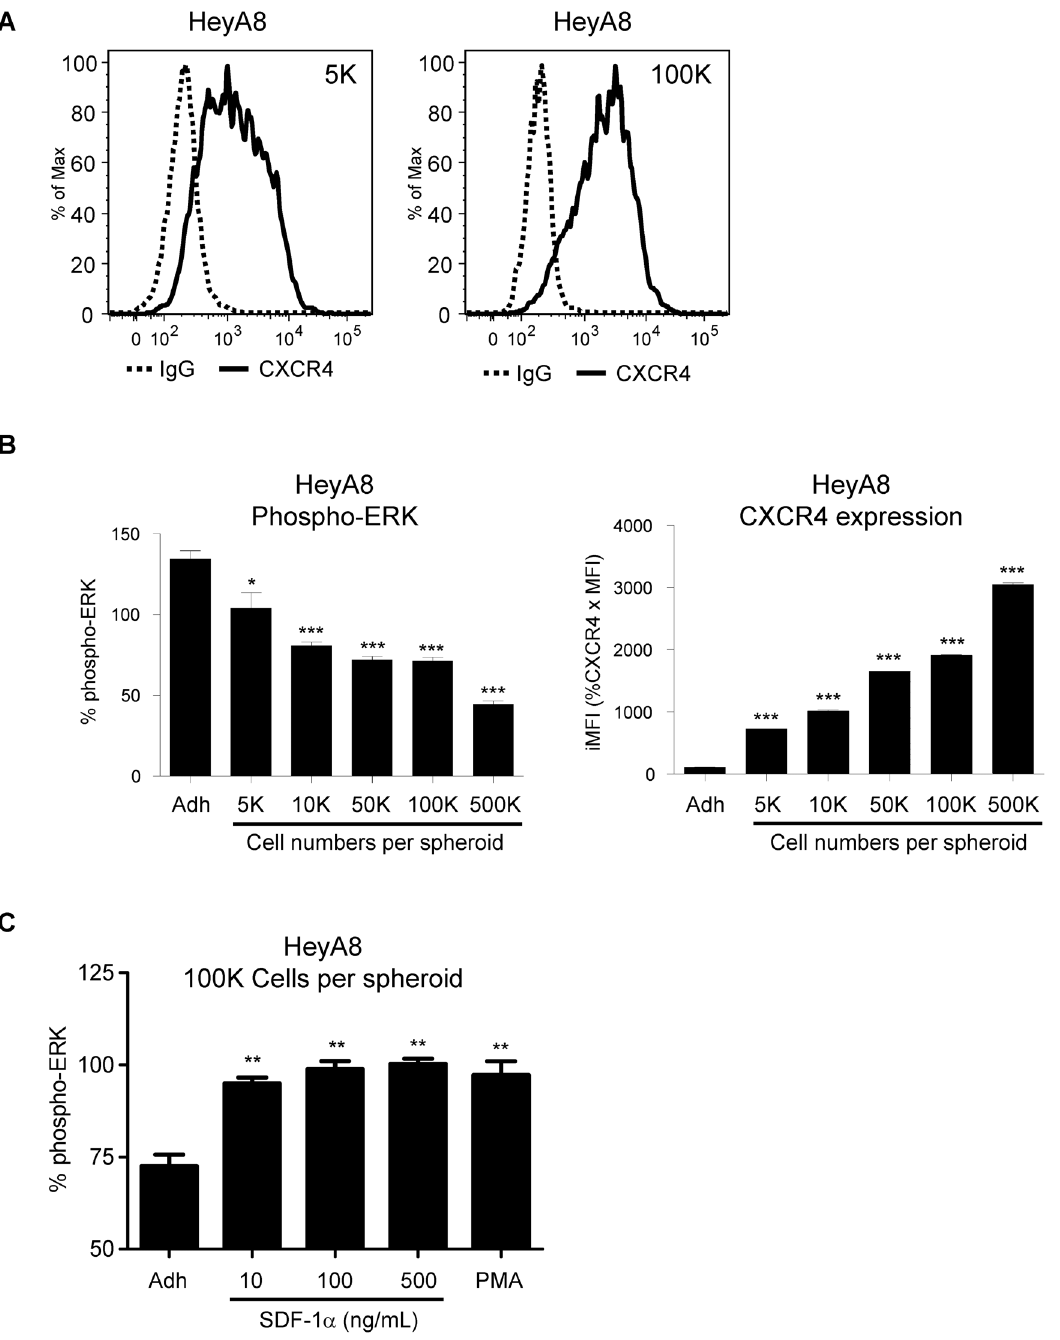
Fig. 3. Phospho-ERK level is decreased in 3D spheroids. HeyA8 cells were cultured as 3D spheroids with different number of cells per spheroid. ( A ) At 5000 cells per spheroid, there was a broad shift in CXCR4 surface expression. At higher cell numbers per spheroid, the expression levels of surface CXCR4 increased. ( B ) Corresponding normalized pERK levels showed a strong correlation between increasing CXCR4 surface expression with decreasing phospho-ERK levels. (*, P , 0.05 vs Adh, 1-way ANOVA) (***, P , 0.0001 vs Adh, 1-way ANOVA). ( C ) At 100,000 cells per spheroid, HeyA8 cells treated with SDF-1 a and PMA showed activation of phospho-ERK levels. (**, P , 0.005 vs Adh, 1-way ANOVA). Each bar graph is representative of 3 experiments.